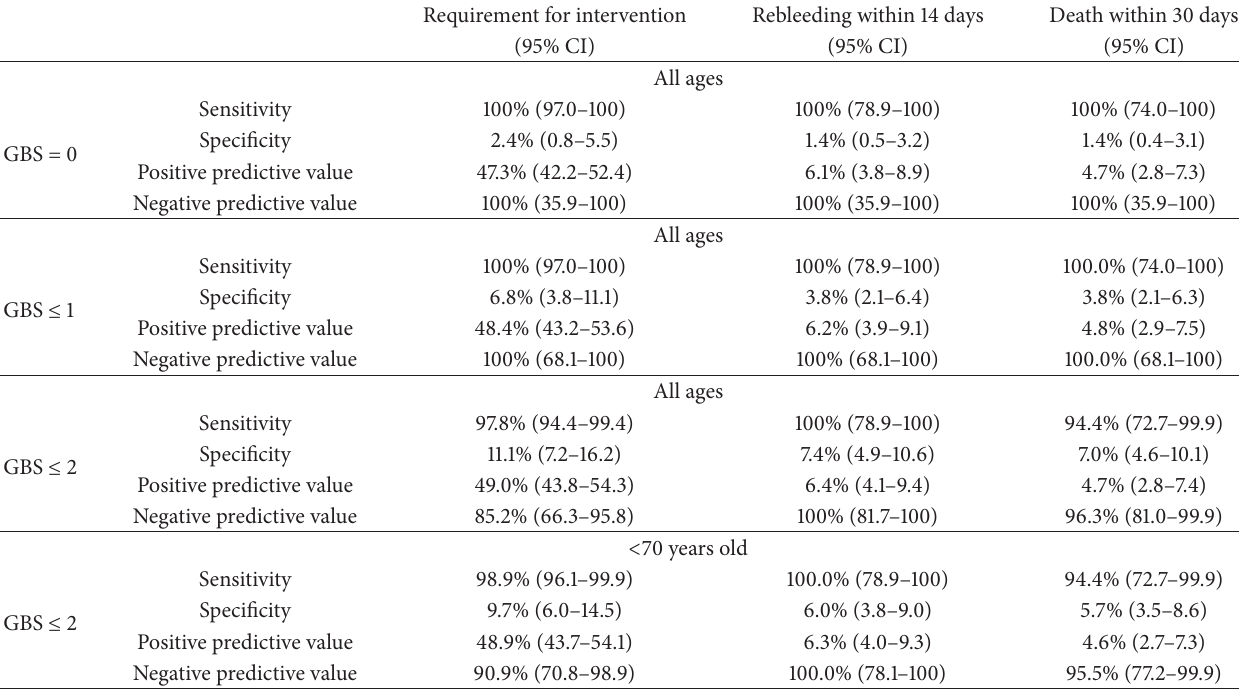
Table 4: Sensitivity and specificity of various Glasgow Blatchford scores for primary and secondary